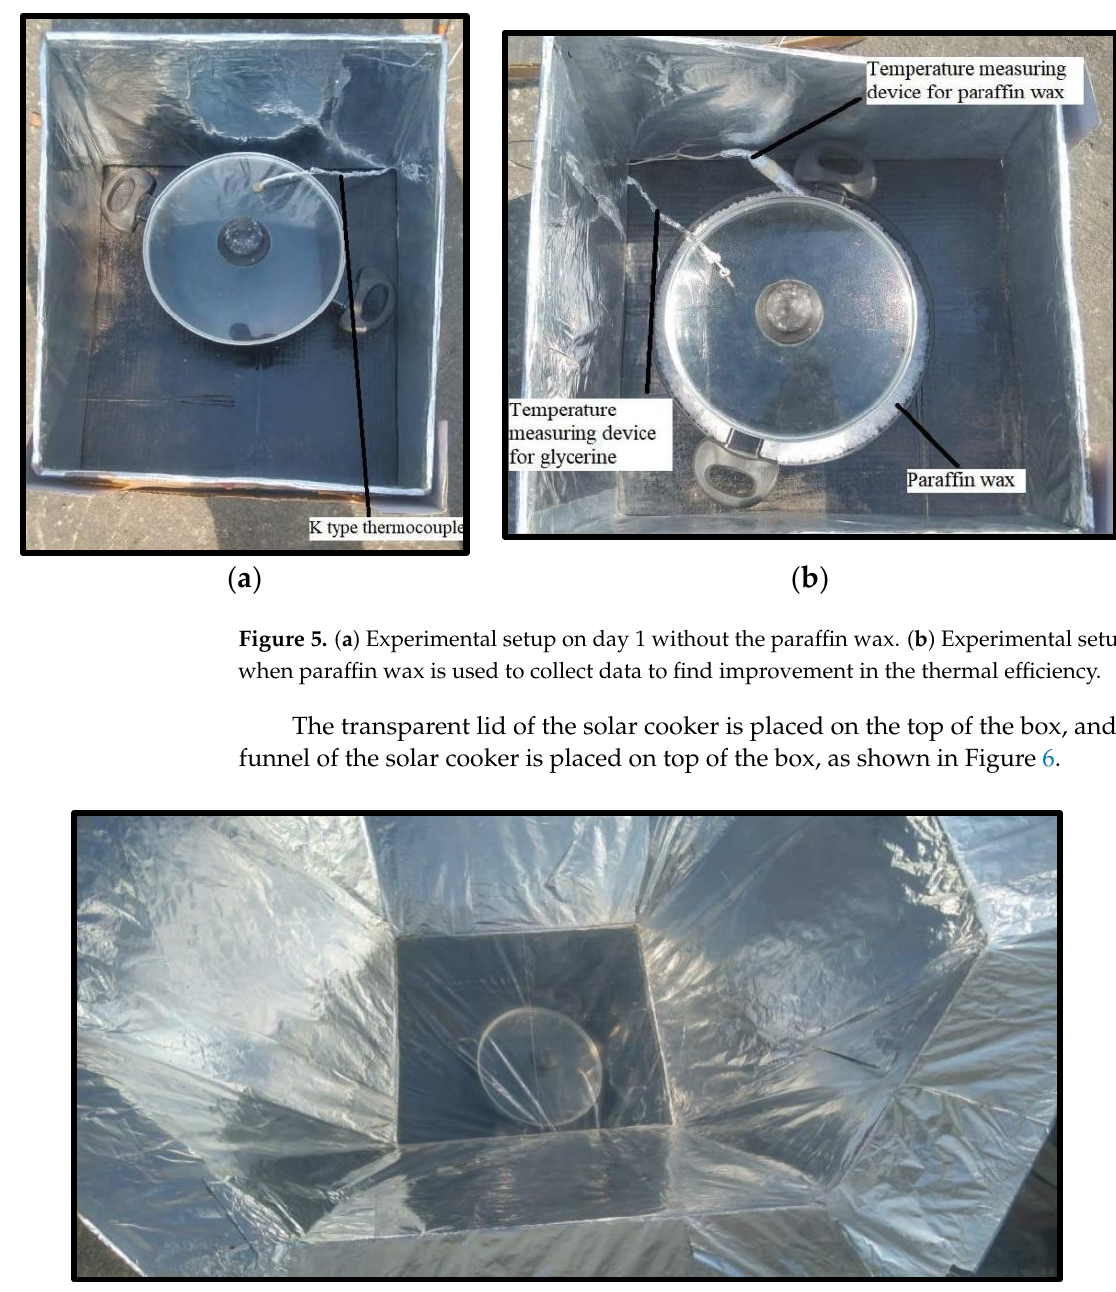
Figure 6. Funnel placed on top of the box. The temperature from various sensors were recorded every minute. The funnel of the solar cooker was adjusted every 30 min according to the position of the sun. The data collected on various days was tabulated and plotted using google sheets. The temperature curve vs. time of various days is shown in Figures 7–11.